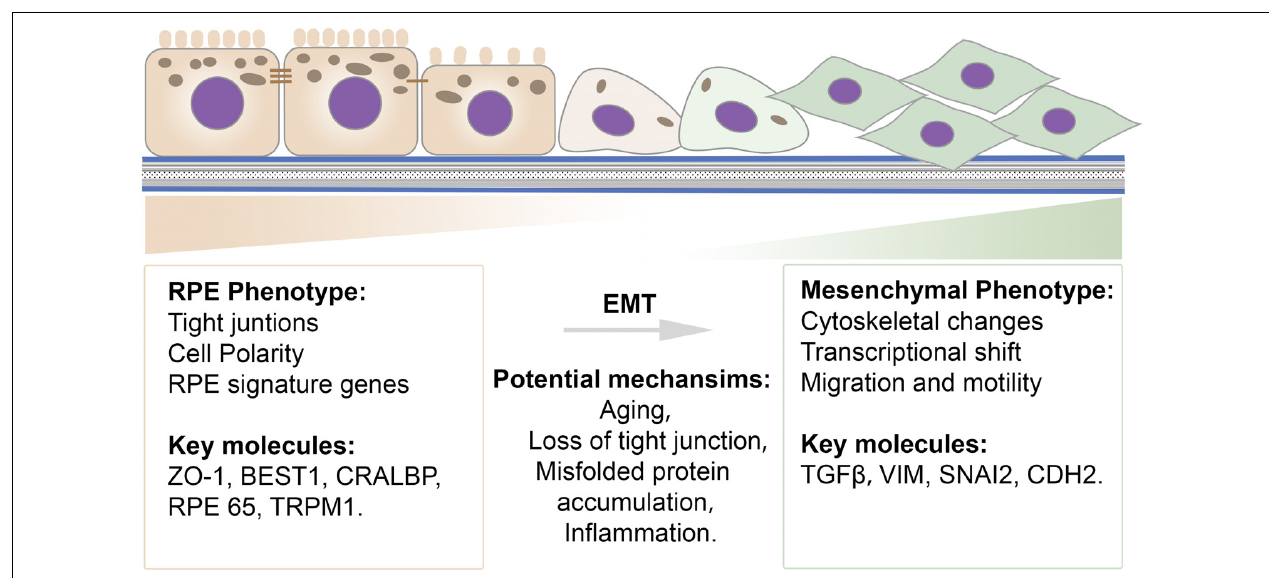
FIGURE 3 | Schematic illustration of the transition spectrum in RPE cells. Common epithelial and mesenchymal cell features and key molecules are listed. RPE cells exhibit a well-differentiated epithelial phenotype that is characterized by integrated tight junctions, high polarization, and proper RPE signature gene expression. A mesenchymal-like phenotype exhibits cytoskeletal changes, a transcriptional shift, and an increased ability for migration. Potential mechanisms contributing to EMT in RPE cells include aging, loss of tight junctions, misfolded protein accumulation and